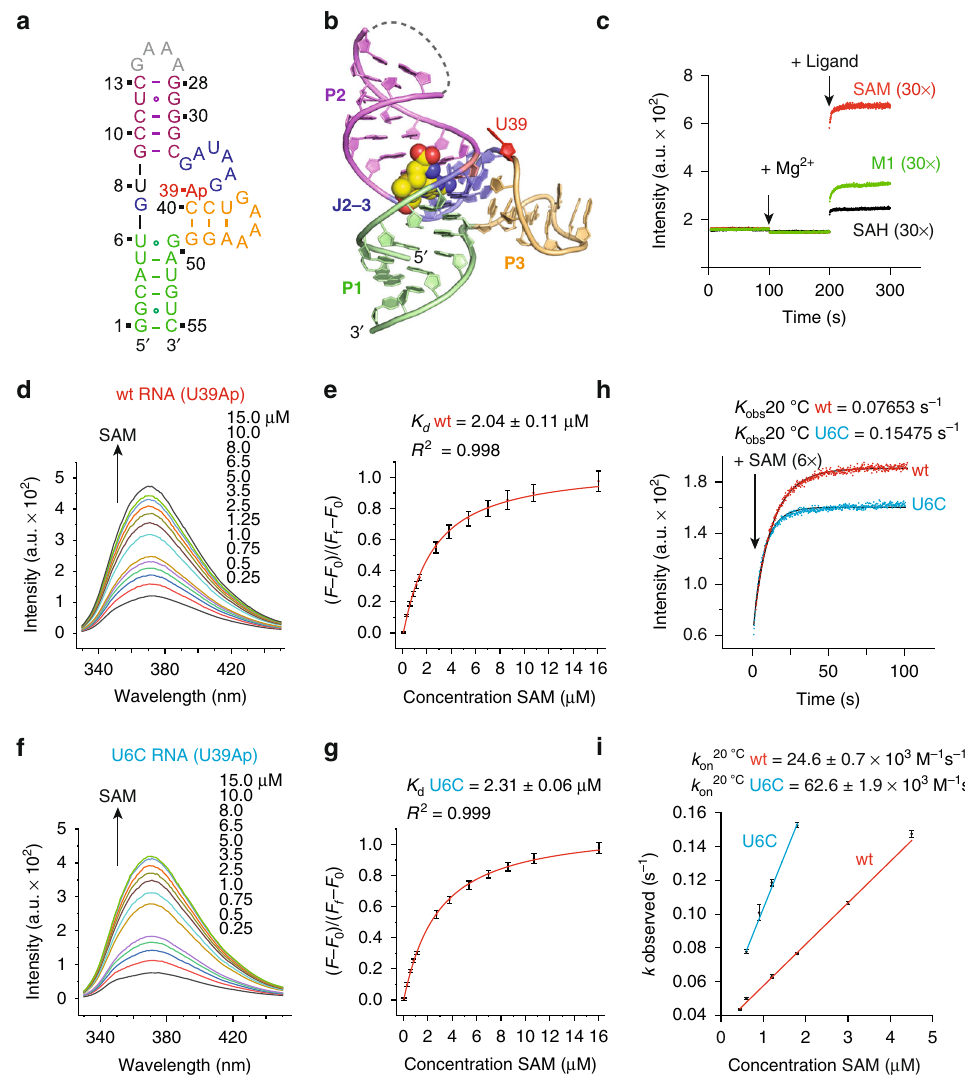
Fig. 4 Kinetics of ligand binding to SAM-VI RNA. a Sequence and secondary structure of the 2-aminopurine (Ap) modi fi ed RNA used for fl uorescence spectroscopic experiments. b The nucleoside U39 (in red) that was selected for Ap replacement is located close to the binding pocket and directed outwards. c Real time fl uorescence traces for SAM-VI riboswitch complex formation, upon Mg 2 + and ligand additions. d Fluorescence changes upon titration of Ap labeled SAM-VI riboswitch variant (wt U39Ap) with ligand SAM; fl uorescence emission spectra ( λ ex = 308 nm) from 330 to 450 nm of the wt U39Ap variant for each ligand concentration. e Normalized fl uorescence intensity of the wt U39Ap variant plotted as a function of SAM ligand concentration. The graph shows the best fi t to a singlesite binding model (see Methods). Changes in fl uorescence ( F - F 0 ) were normalized to the maximum fl uorescence measured in saturating concentrations of the SAM ligand. The obtained K d (Ap) values (50 mM KMOPS, pH 7.5, 100 mM KCl, 2 mM MgCl 2 , 293 K) were slightly higher compared to the K d values obtained from ITC titration experiments that were performed at 10 mM Mg 2 + concentrations. f , g Same as d , e but for titration of the U6C U39Ap variant with SAM ligand. For further details, see Methods. h Stopped- fl ow fl uorescence spectroscopy was used to monitor the kinetics of SAM-VI riboswitch complex formation using wild-type (wt) and U6C SAM-VI RNAs. Exemplary fl uorescence traces are depicted; conditions: 0.3 μ M RNA, 100 mM KCl, 50 mM MOPS, pH 7.5, 293 K. Ligands: 2 mM MgCl 2 , 1.8 μ M ligand. i The mean k obs values determined from three independent experiments with the corresponding error bars are plotted against the concentration of SAM and subjected to a linear fi t. The slope of the plot yields the rate constant k on